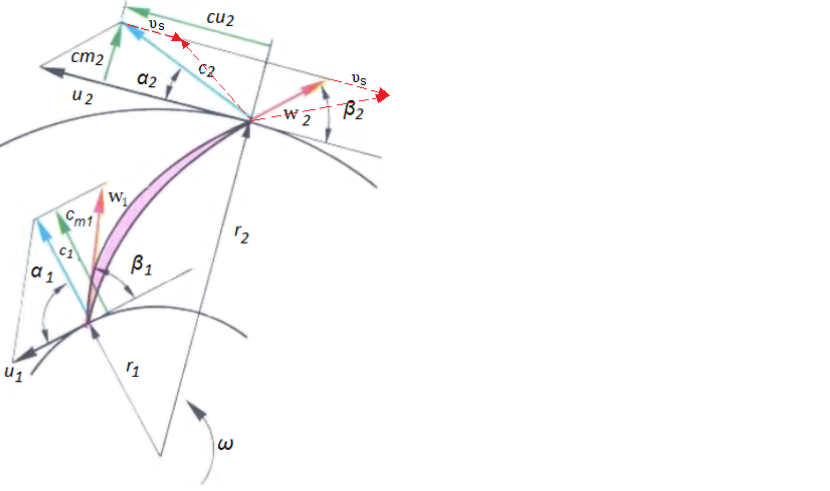
Figure 3. Velocity triangles at the inlet and outlet of the impeller in pump operation under design conditions (BEP) with slip deviation.